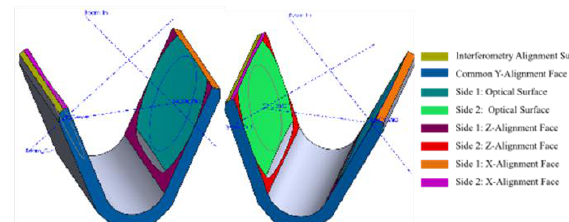
Figure 2 : Fiducial system for each side of the light weight monolith.